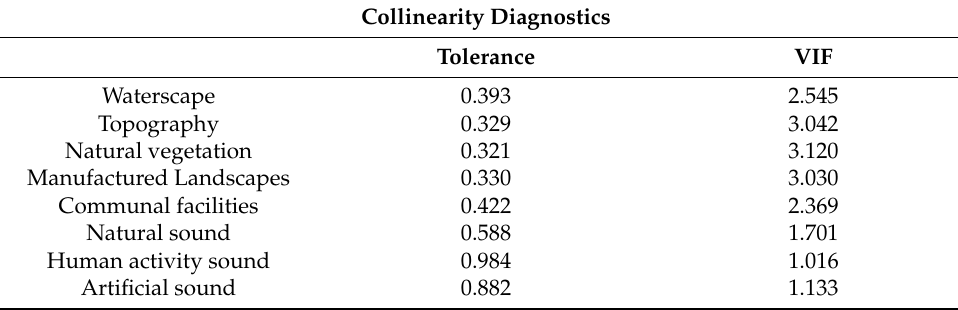
Table 8. Collinearity